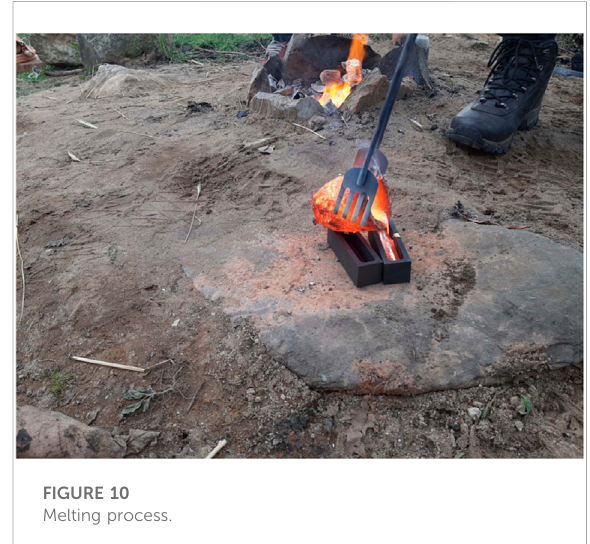
FIGURE 10 Melting